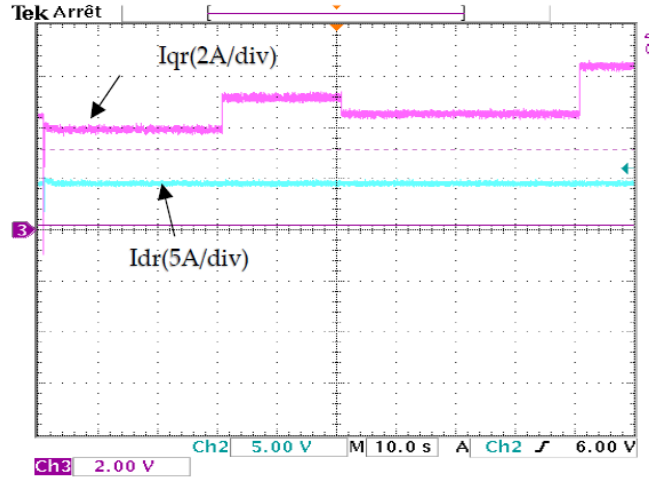
Figure 10. Active and reactive power.